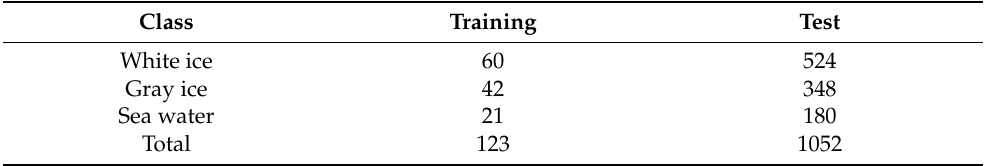
Table 7. Correlation matrix for eight texture components in the Baffin Bay data set.